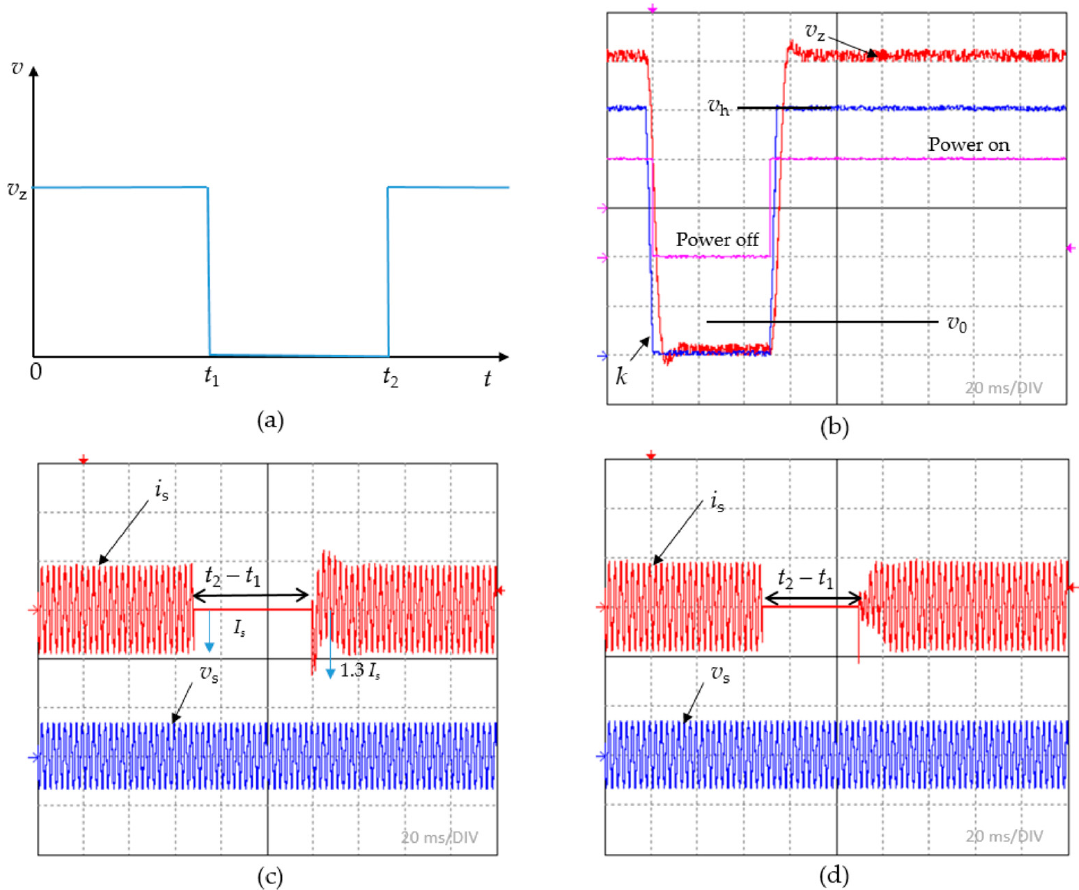
Figure 7. Dynamic response of the system to a voltage change on power bus 4: ( a ) assumed voltage profile on bus 4; ( b ) waveforms of the recorded voltage of bus 4 v z , correction factor k, and supply voltage identifier (pink color); waveforms of current i s and voltage vs. of bus 2 recorded in the standard system ( c ) and in the proposed system ( d ).